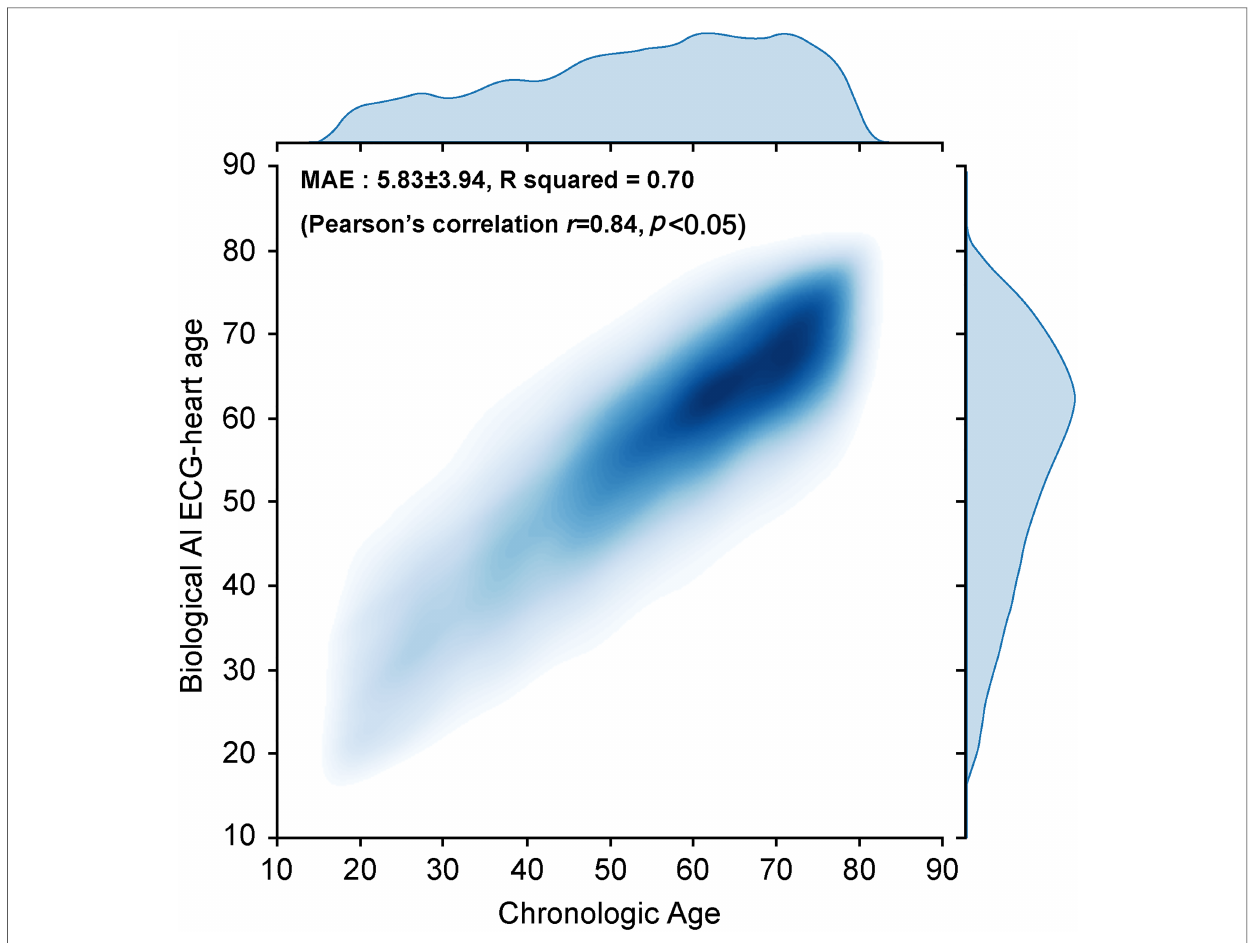
FIGURE 3 Correlation between the AI-estimated biological ECG heart age and chronological age shown via a heat map. AI, arti fi cial intelligence; ECG, electrocardiography; MAE, mean absolute